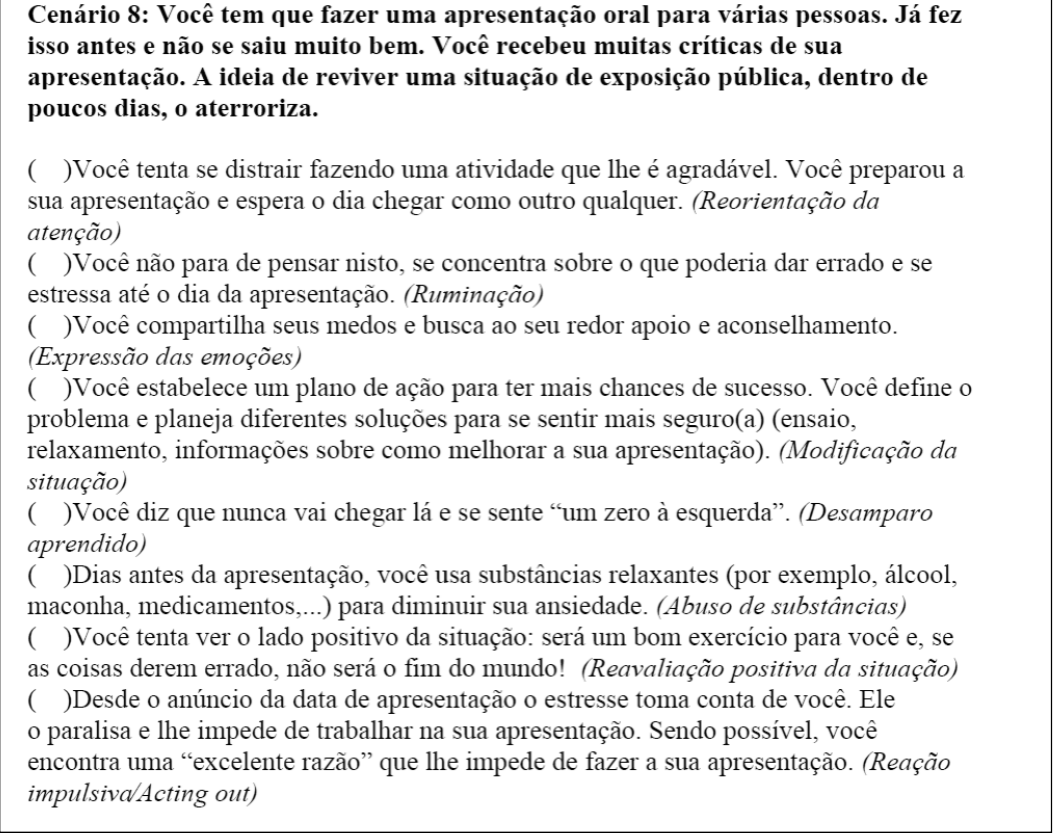
Figura 2. Exemplo de cenário de medo com as opções de